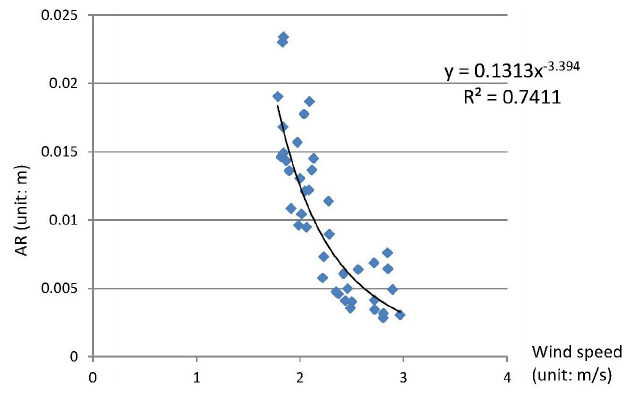
Figure 6. Relationship between the average wind speed and the AR at A’rou station.